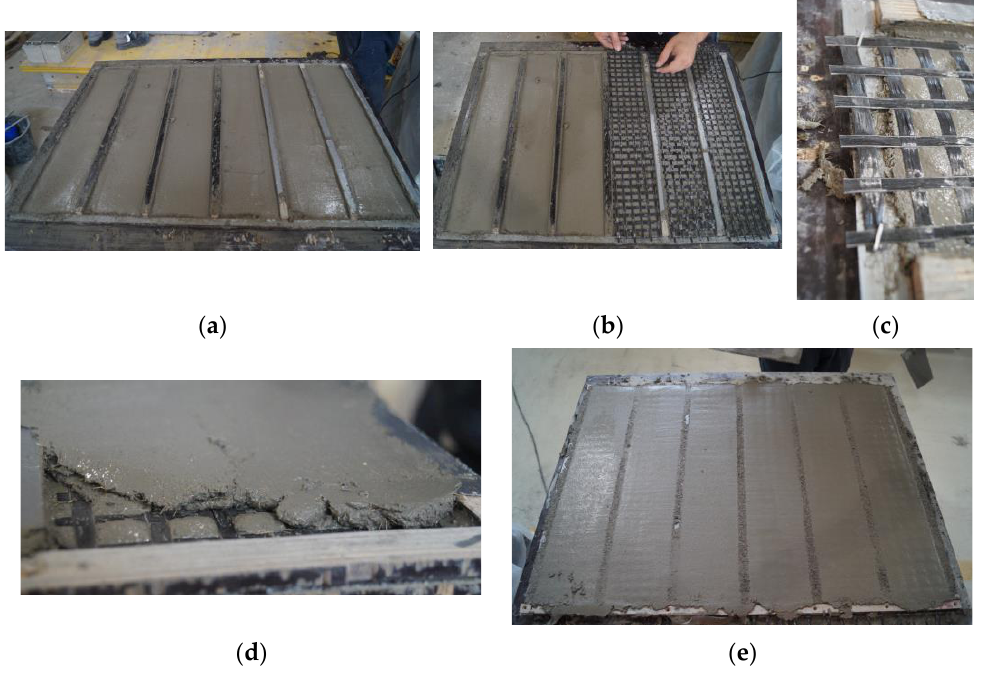
Figure 2. Details of the design for specimens of series A and series B. In ( a ), the first layer of cementitious matrix is applied; in ( b ), the basalt textile fabric is placed over the cementitious matrix; in ( c ), is shown a detail of how textile fabric is fixed on the wooden formwork; in ( d ), the last layer of cementitious matrix is applied; and in ( e ) is shown the specimens when the production process is concluded.